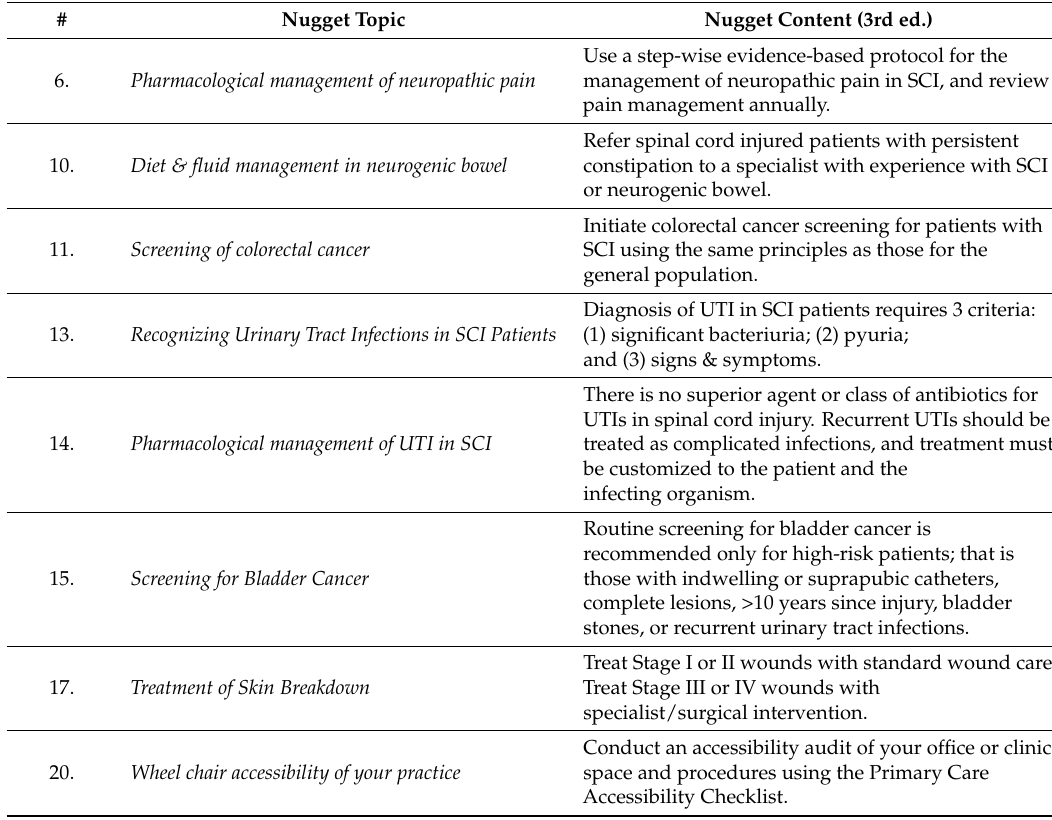
Table 3. 8 Nuggets with major